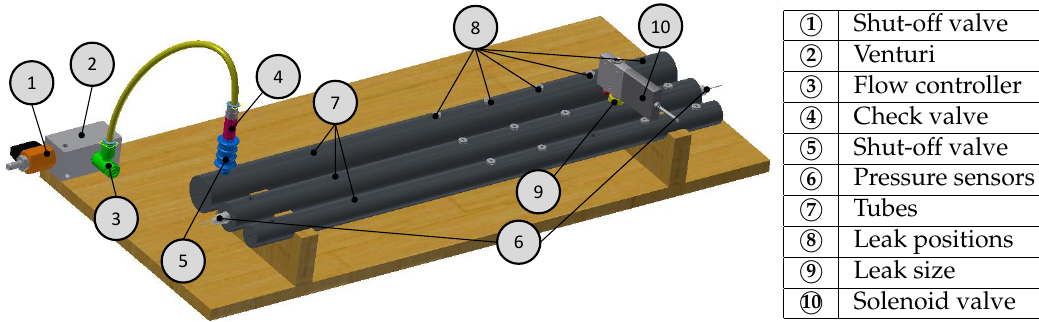
Figure 5. Graphical presentation of the test